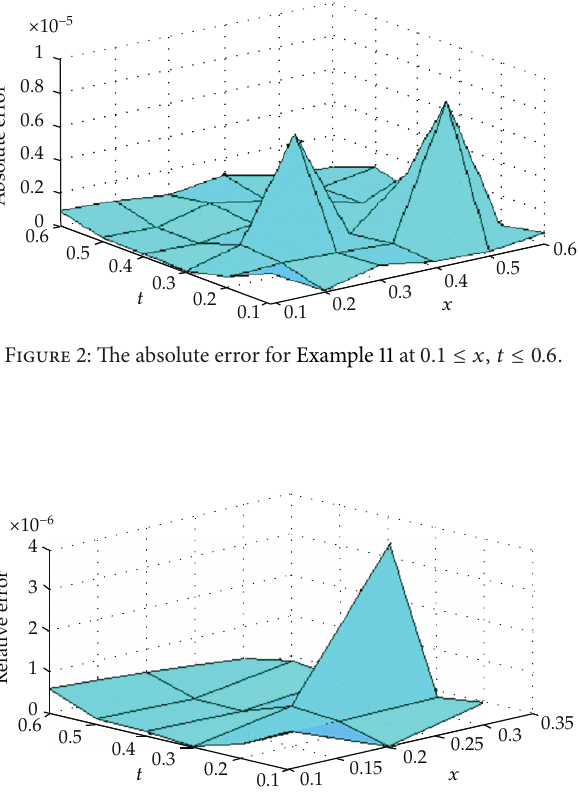
Figure 3: The relative error for Example 11 at 0.1 ≤ 𝑥 , 𝑡 ≤ 0.6